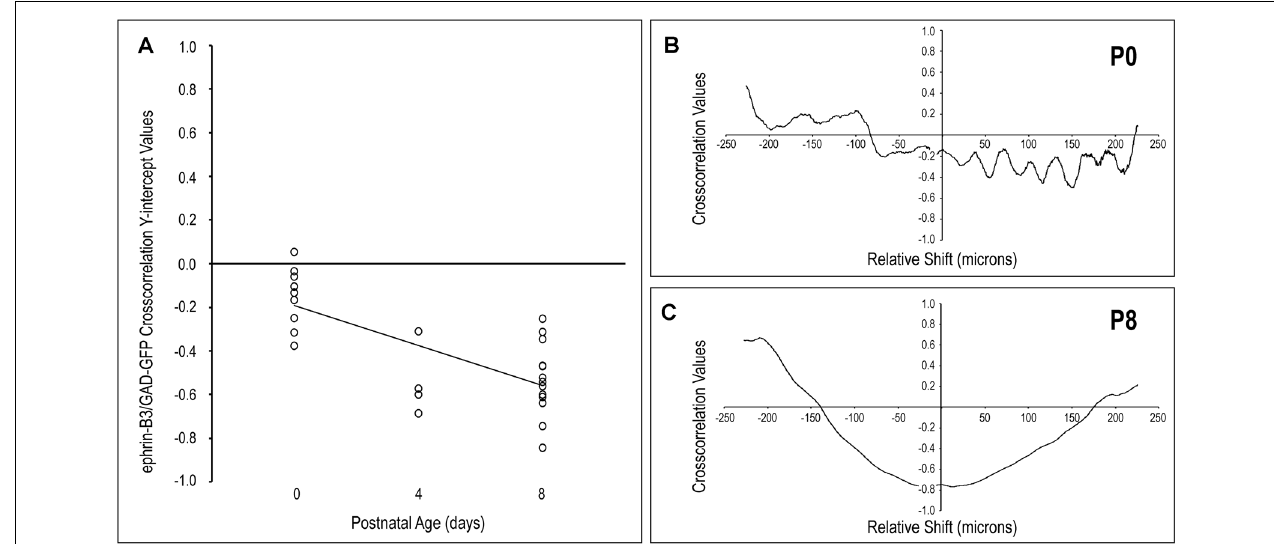
FIGURE 2 | Quantification of LCIC ephrin-B3 expression patterns relative to GAD modular expression over the early critical period. The negatively sloped linear regression of cross-correlation y-intercept values with age (A) supports the observed developmental trend that ephrin-B3 patterns become increasingly extramodular and offset from emerging GAD-positive layer 2 modules. The absence of any prominent values in P0 cross-correlation functions [representative plot shown in panel (B) ] indicates the lack of any significantly similar pattern features between ephrin-B3 and GAD-positive signals at birth. In contrast, by P8 [representative plot shown in panel (C) ] pronounced negative cross-correlation y-intercepts and smooth transitions to prominent positive cross-correlation values at shifts of approximately ± 200–250 µ m indicate a significant mismatch between signal features at zero relative signal shift and again at regular intervals in keeping with the discontinuous LCIC compartmental arrangement at this